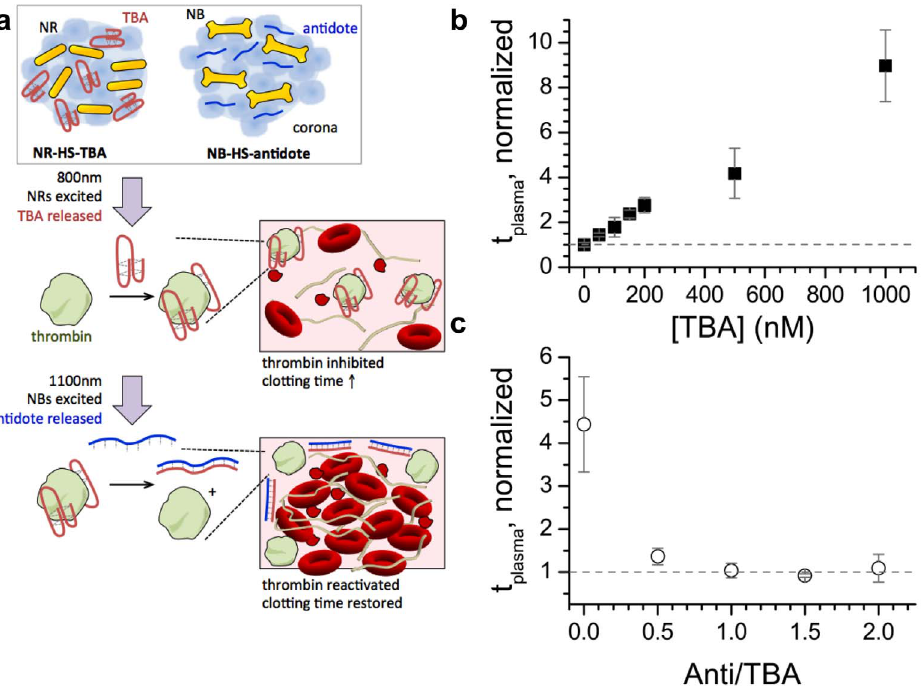
Figure 1. TBA and antidote affect coagulation in whole human blood. a) Schematic of coronas made from human serum (HS) loaded with NRs and TBA (NR-HS-TBA) + coronas loaded with NBs and antidote (NB-HS-antidote). 800 nm laser irradiation melts the NRs, triggering release of TBA from the coronas, which inhibits thrombin and causes blood coagulation times to increase. Following this, 1100 nm laser irradiation melts the NBs, triggering release of the DNA antidote from the corona. The antidote forms a double-stranded hybrid with TBA, thus restoring thrombin activity and blood coagulation. Fluorescently labeled TBA has a sequence of 5’ GGTTGGTGTGGTTGG-TMR 3’. The fluorescently labeled antidote has the complementary sequence 5’ CCAACCACACCAACC-FAM 3’. Clotting time ( t plasma ) for a thrombin test using 10 nM thrombin measured by a coagulometer with b) TBA, for c) 500 nM TBA + varying antidote from [anti] = 0 to 1000 nM (anti/TBA = 0 to 2.0).